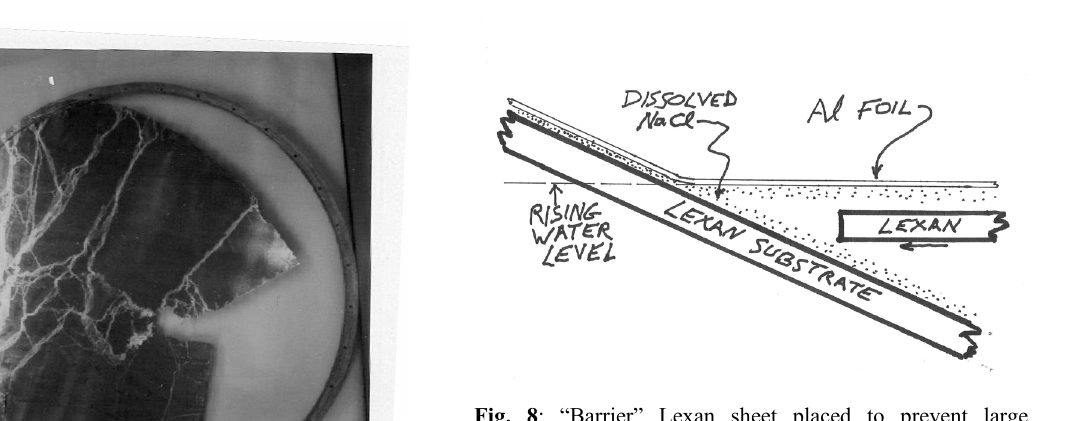
Fig. 5: Convection in a parting-agent-water system.